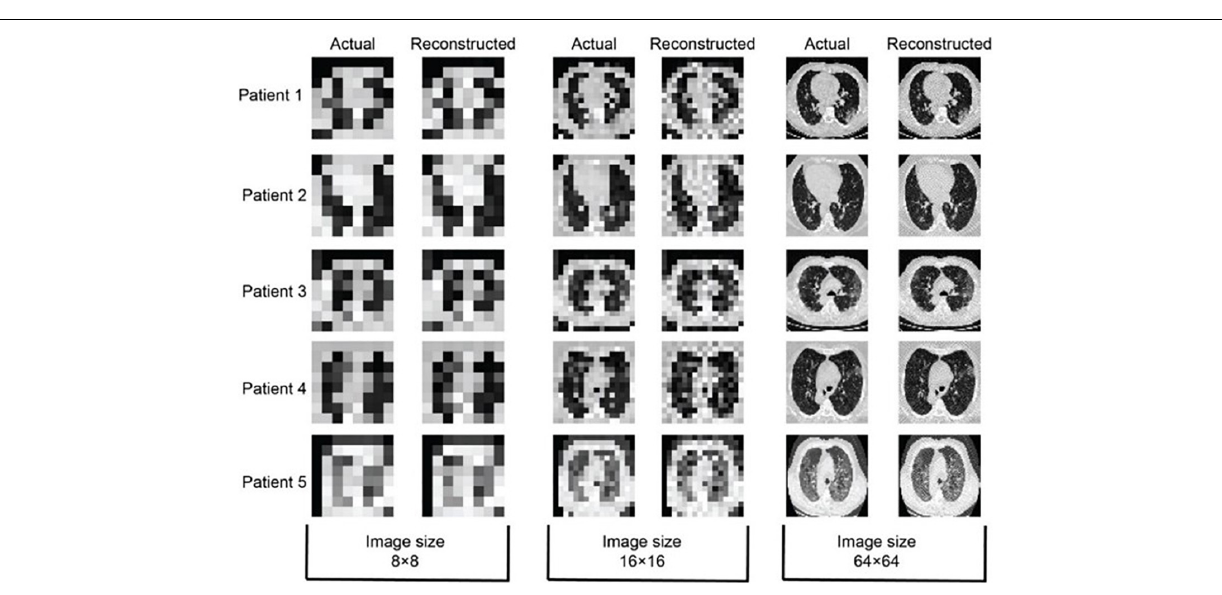
FIGURE 7 | 8 × 8, 16 × 16, and 64 × 64-sized COVID-19 reconstructed images using simulated annealing with RMSLE as cost function ( p = 18, T 0 = 0.1, T N = 1 × 10 − 6 , N = 2 × 10 5 , temperature slab thickness set to 1000, and temperature profile as given by Eq.